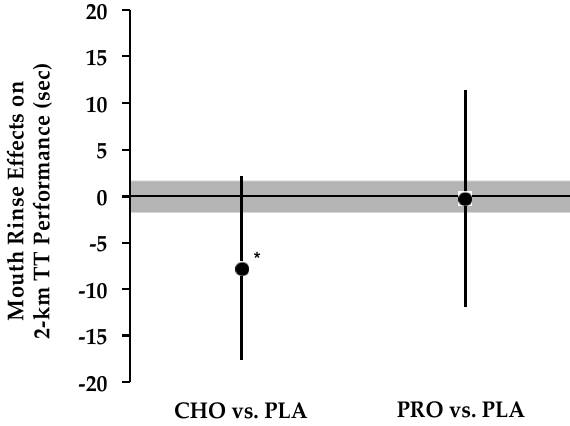
Figure 2. Effect of CHO and PRO mouth rinses on 2 km time trial (TT) Performance. Circles represent mean treatment difference compared to placebo. Bars depict 90% confidence interval. Shaded area notates threshold value for smallest meaningful effect. * ‘Likely’ faster than PLA. Table 2. The 2 km performance, peak strength, and heart rate, rating of perceived exertion, and glucose.